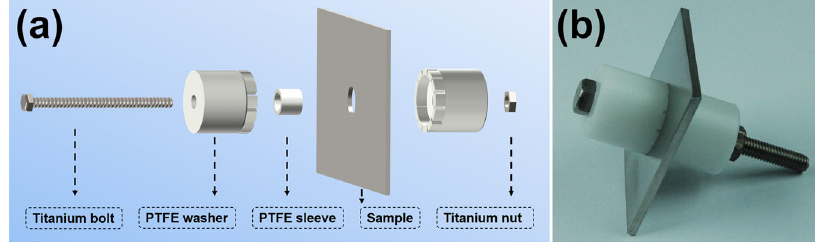
Fig. 15 Schematic diagram of the multi-crevice assembly. a detailed diagram, b photograph of the fi nal assembly.